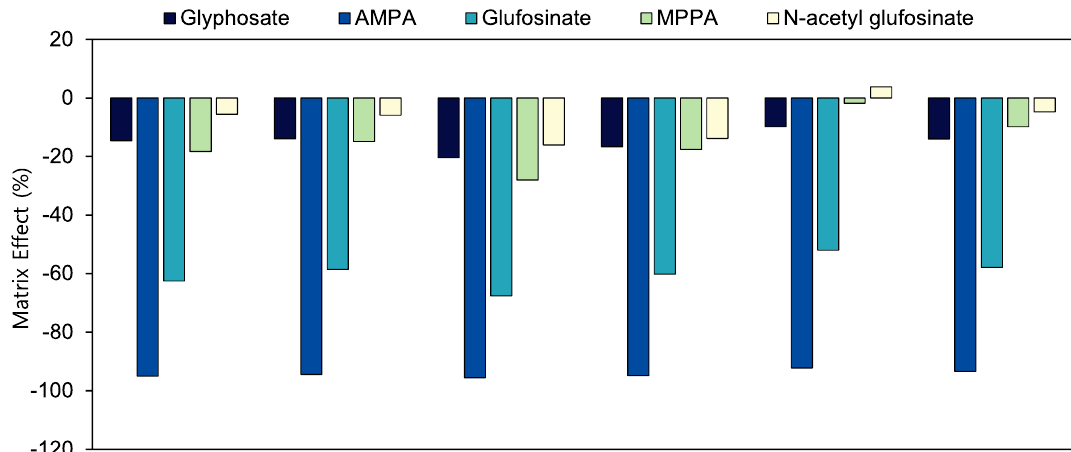
Figure 5. Matrix effects of glyphosate aminomethylphosphonic acid (AMPA), glufosinate, 3-methylphosphinico-propionic acid (MMPA), and N -acetyl glufosinate obtained after seven different cleanup procedures were performed after sample extraction with DW (15 mL) acidified with 100 µL formic acid and MeCN (5